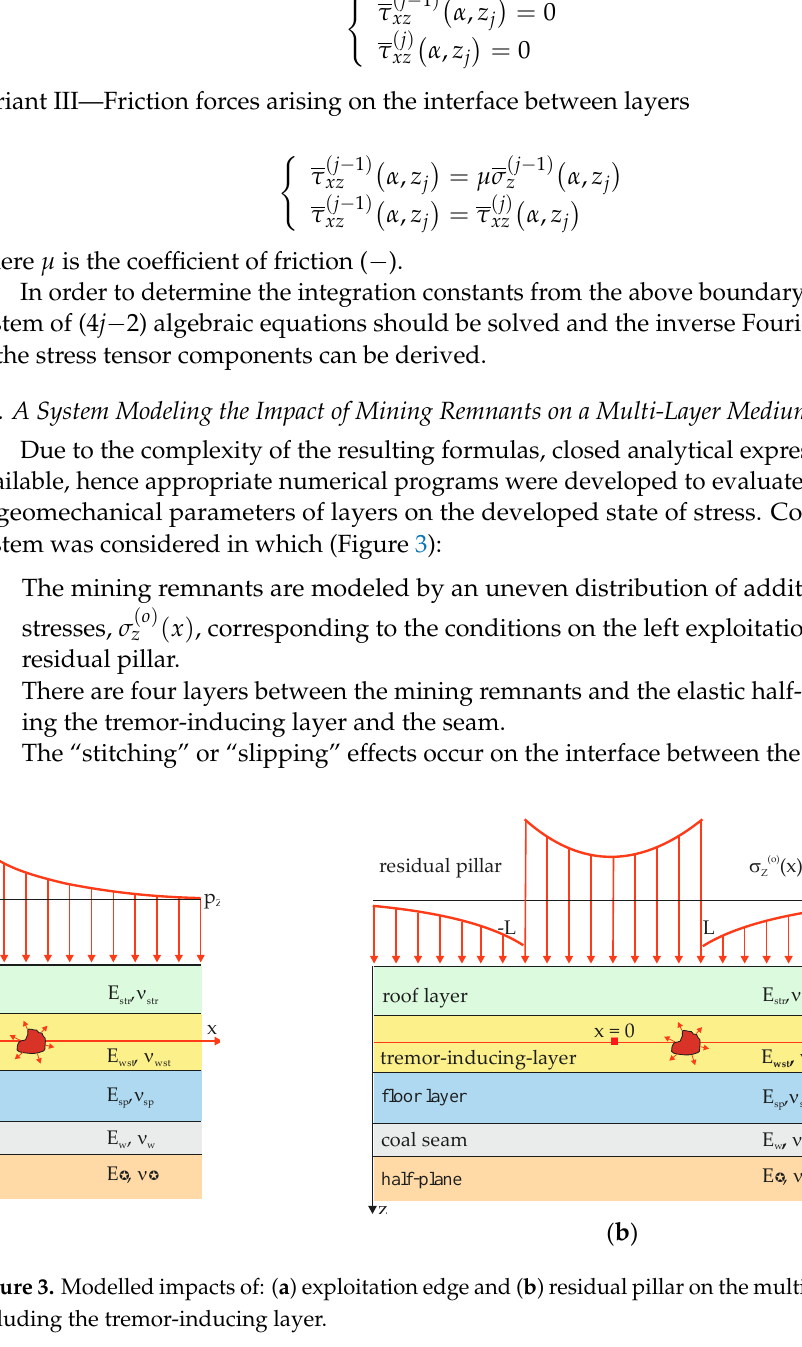
Figure 4. A model of goafs and undisturbed coal body. −